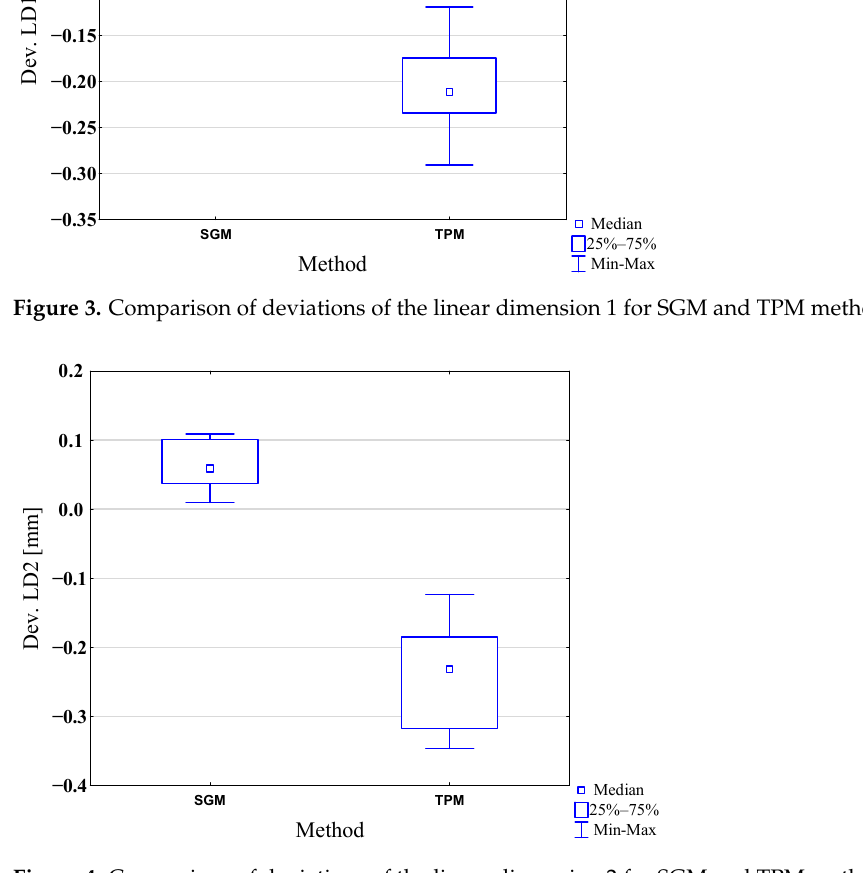
Figure 4. Comparison of deviations of the linear dimension 2 for SGM and TPM methods.